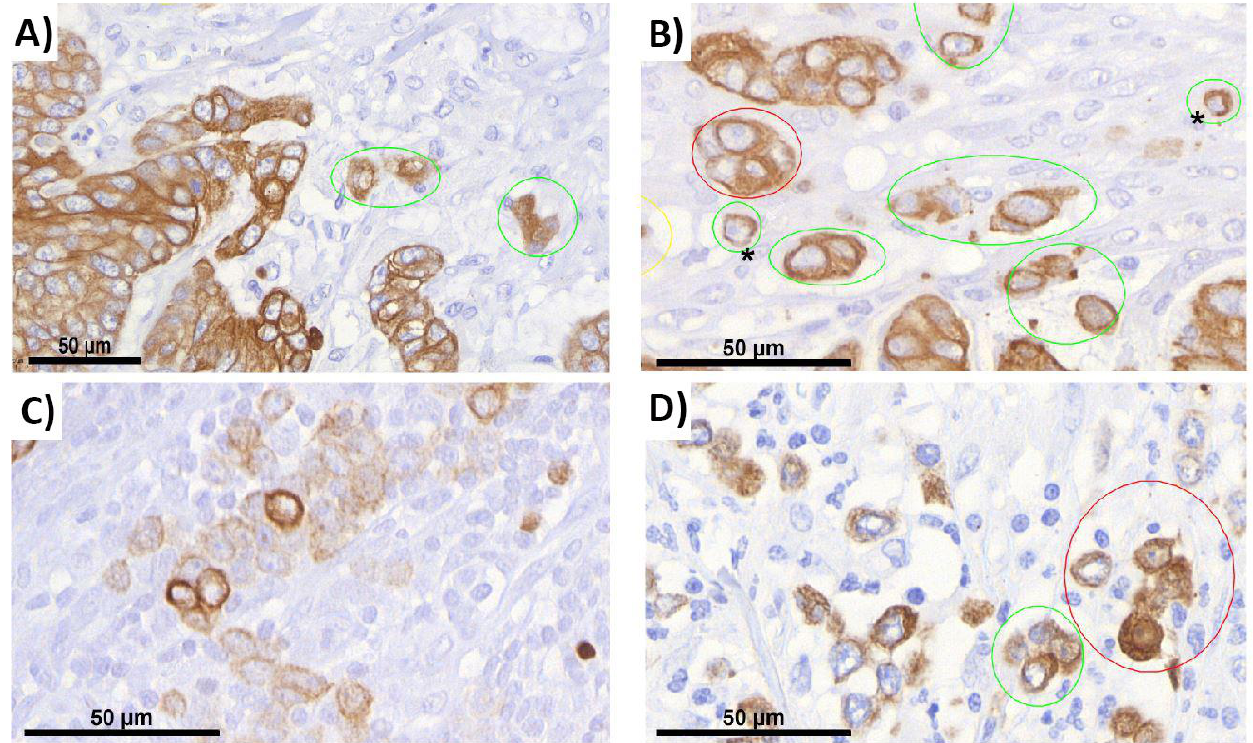
Figure 1. Budding analysis—cell properties. Histological specimens were stained using antibodies AE1/AE3 according to the manufacturer’s recommendations. They were scanned using 3DHISTECH PANNORAMIC 250 Flash II with a CIS VCC camera (3DHISTECH Ltd., Budapest, Hungary) and a 40× Plan-Apochromat objective (Karl Zeiss, Jena, Germany) and a resolution of 0.194 µm/pixel, scan compression setting 80 jpg. The digital slides were analyzed using CaseViewer (Ver. 2.4., 3DHISTECH Ltd., Budapest, Hungary). Tumor buds were marked in pictures using the annotation tool in CaseViewer. The different histological aspects of cell properties that were important for analyzing buds can be seen in ( A – D ). The cells marked with a green circle were those considered as real buds, whereas cells marked with a red circle did not fulfill the criteria to be considered buds. ( A ) Low intensity staining: the cells on the left side marked in green have a lower staining intensity than the cells on the right. There are weakly stained cells in the tumor. Therefore, the staining intensity of cells on the left side is an average of the staining intensity of the whole tumor, and they were considered as buds on this basis. Magnification: 62.1 × . ( B ) Incomplete circumference: the cells marked with (*) do not have a continuous circumference. They were still considered buds because the circumference exceeds 50% of the cell. Morphologically, the cell is very similar to a tumor cell. It has a light halo and has a size comparable to the average cell size of the rest of the surrounding tumor cells. Magnification: 102.8 × . ( C ) Positive and negative cells: as shown, strongly stained cells can be found at the center of a group of many negative cells. Positive cells can mistakenly be evaluated as real buds. The negative cells must also be considered and are very close. They form a unit together with the strongly stained cells and thus exceed the maximum count of 4 for a real bud. Therefore, the strong positive cells are not considered a bud. Magnification: 102.8 × . ( D ) Cell count limit: the image shows the limit for maximum cell numbers at which a cell group is no longer considered a bud (>4 cells). The cell group marked in green consists of four cells and thus fulfills the criterion regarding the maximum cell count of a bud (considering distance to other groups of cells). The cell group marked in red consists of five cells. This exceeds the maximum number and, thus, cannot be considered a bud. Magnification: 102.8 ×